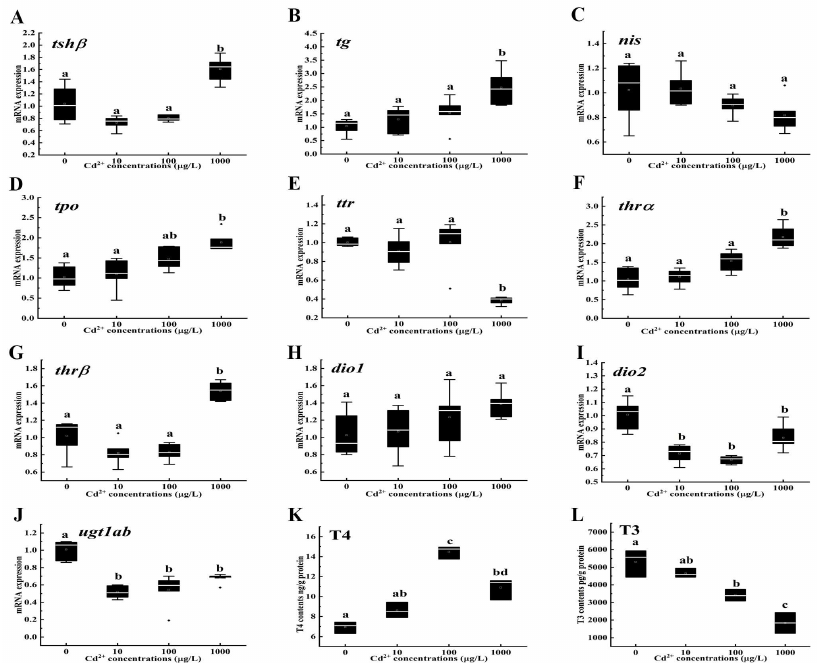
Figure 1. Transcription levels of tsh β ( A ), tg ( B ), nis ( C ), tpo ( D ), ttr ( E ), thr α ( F ), thr β ( G ), dio1 ( H ), dio2 ( I ), ugt1ab ( J ) and contents of T4 ( K ), T3 ( L ) in zebrafish embryos (2 hpf) that were treated with Cd 2+ (0, 10, 100, and 1000 μg/L) for 120 h. Data are shown as mean ± SD (n = 6). Different letters denote significant differences between groups ( p < 0.05).